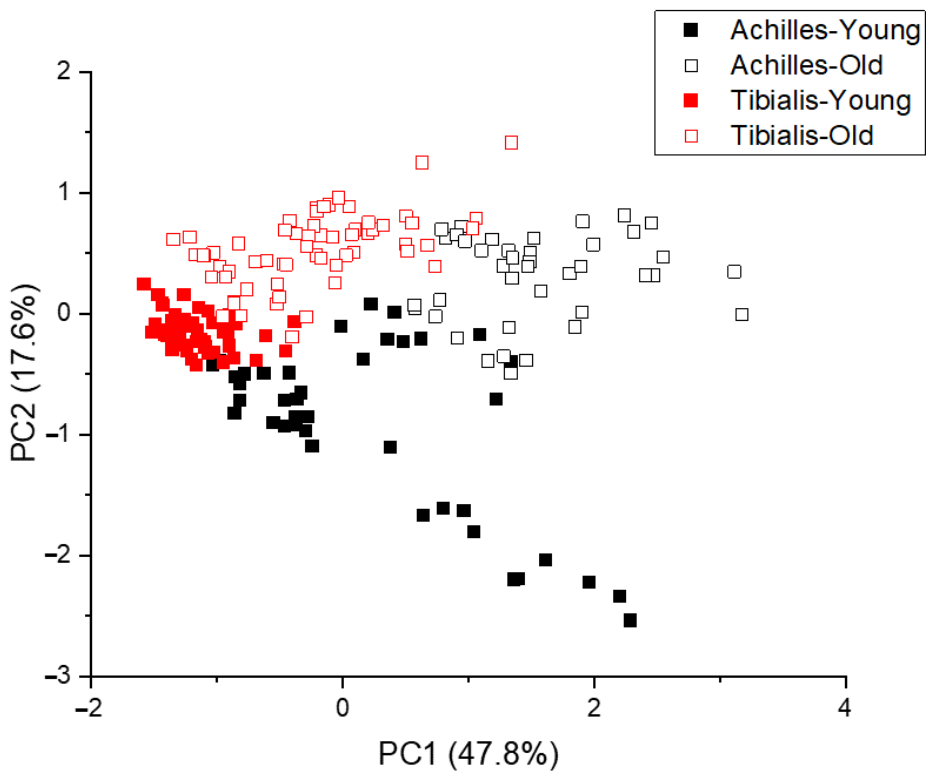
Figure 2. Principle component analysis of pooled Raman spectra (n = 160).